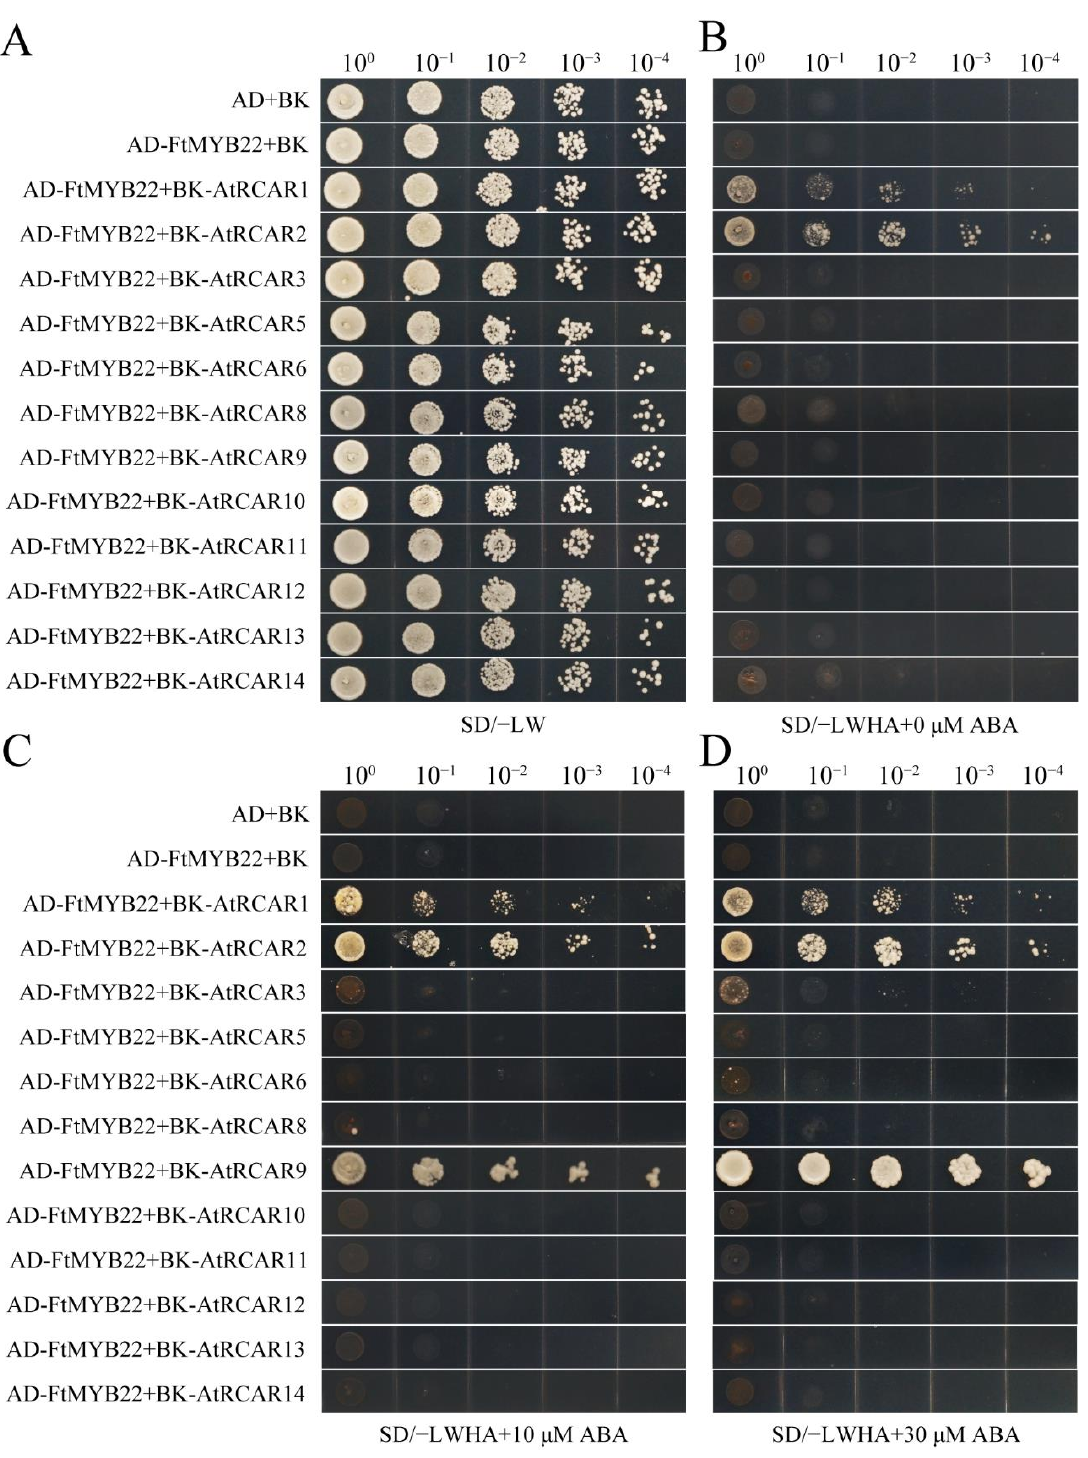
Figure 15. Molecular interactions between FtMYB22 and AtRCARs by Y2H. ( A , B ) The yeast cells carrying the plasmids as indicated were cultured on SD/ − Leu/ − Trp medium (SD/ − LW) and SD/ − Trp/ − Leu/ − His/ − Ade medium (SD/ − LWHA). ( C , D ) The yeast cells carrying the plasmids as indicated were cultured on SD/ − Trp/ − Leu/ − His/ − Ade medium containing 10 μM and 30 μM of ABA. The yeast cells containing recombinant plasmid as were serially diluted by 1, 10, 100, 1000, and 10,000